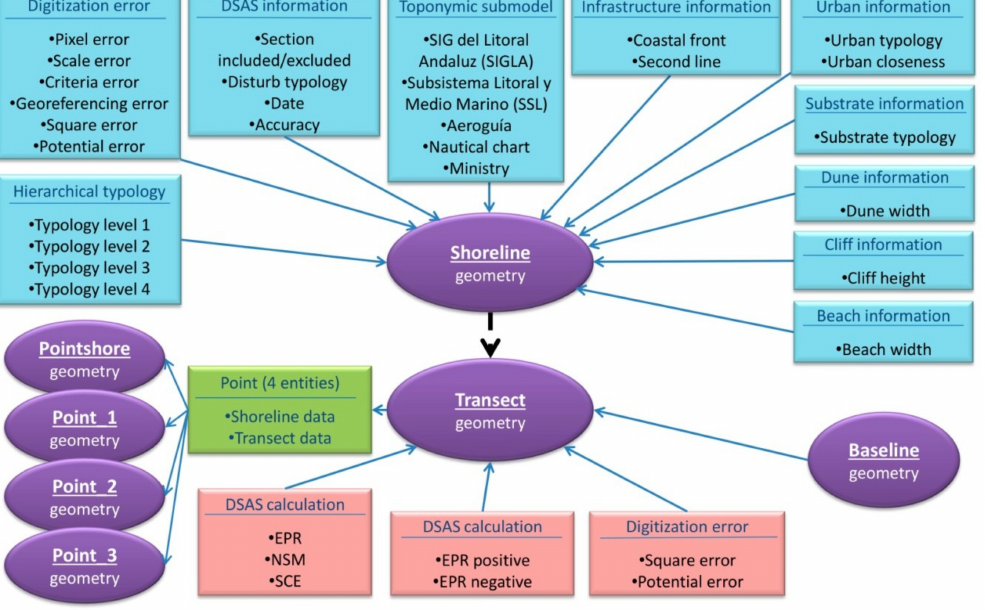
Figure 3. Erosion data model developed for this